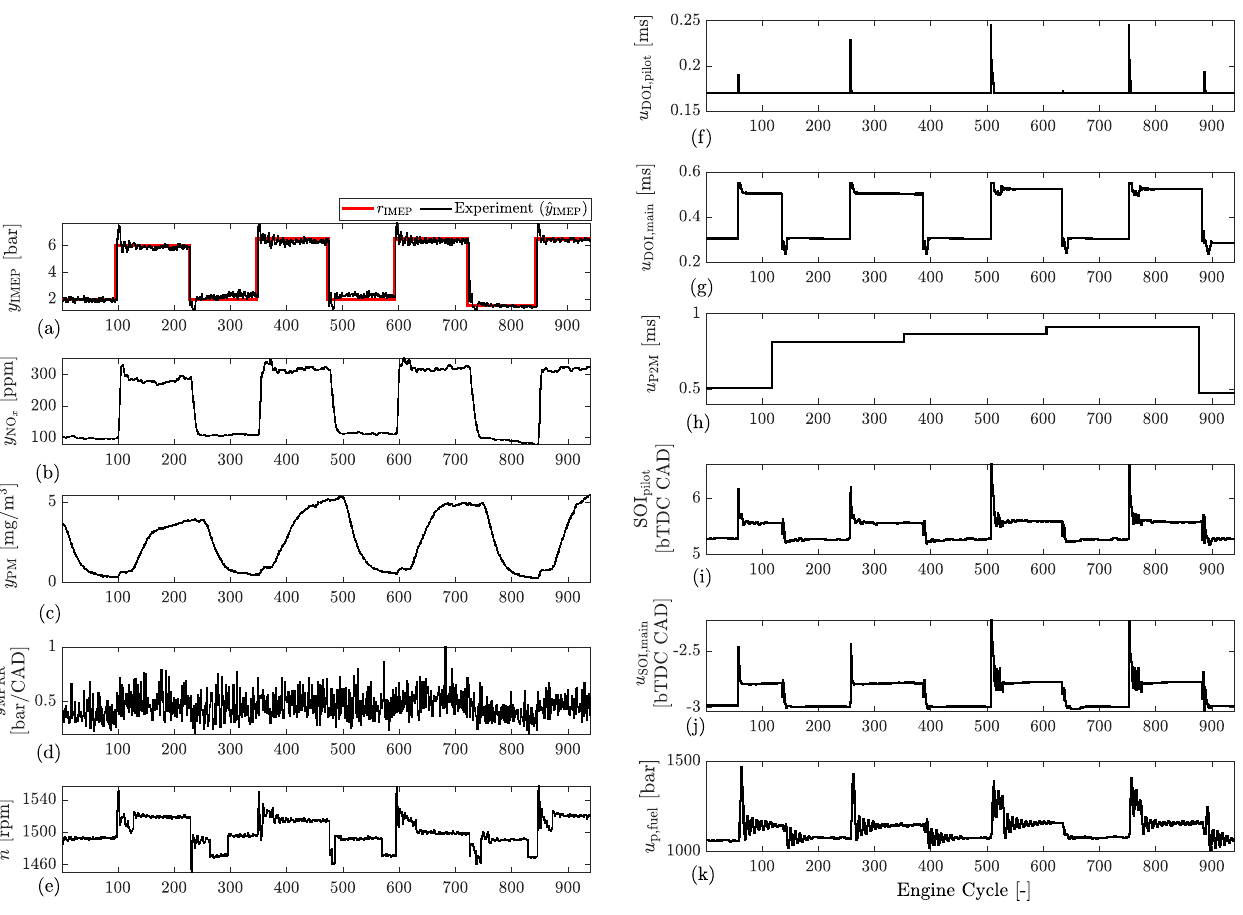
Figure 10. Experimental results: step changes in IMEP at n = 1500 rpm—( a ) indicated mean effective pressure (IMEP), ( b ) nitrogen oxide (NO x ), ( c ) Particle Matter (PM), ( d ) maximum pressure rise rate (MPRR), ( e ) engine speed, ( f ) duration of injection (DOI) of pilot injection, ( g ) DOI of main injection, ( h ) duration between end of pilot injection and start of main injection, ( i ) start of injection (SOI) of pilot injection, ( j ) SOI of main injection, ( k ) fuel rail